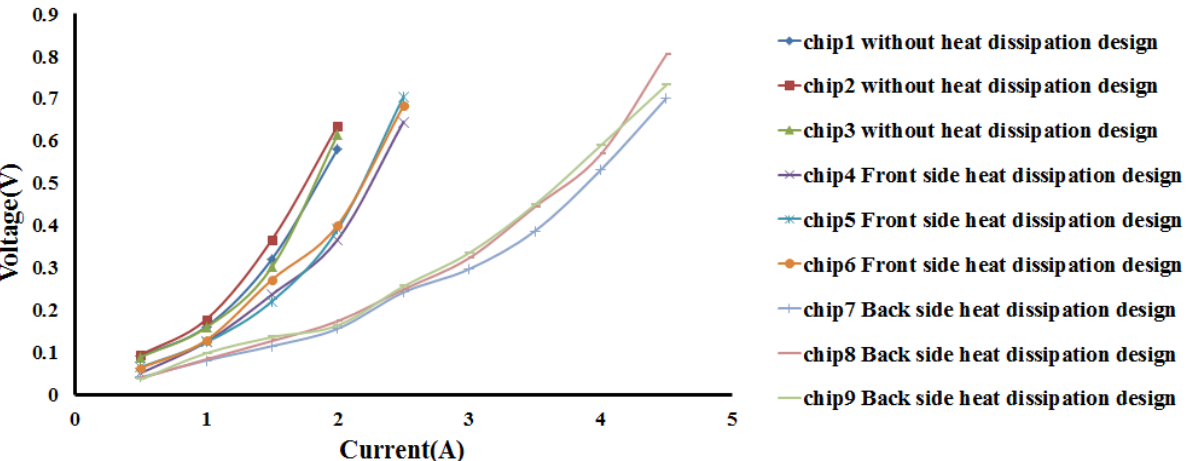
Figure 8. Measured voltage as a function of applied current on atom chips with different heat dissipation design. All the measurements stop at a certain point where the wires